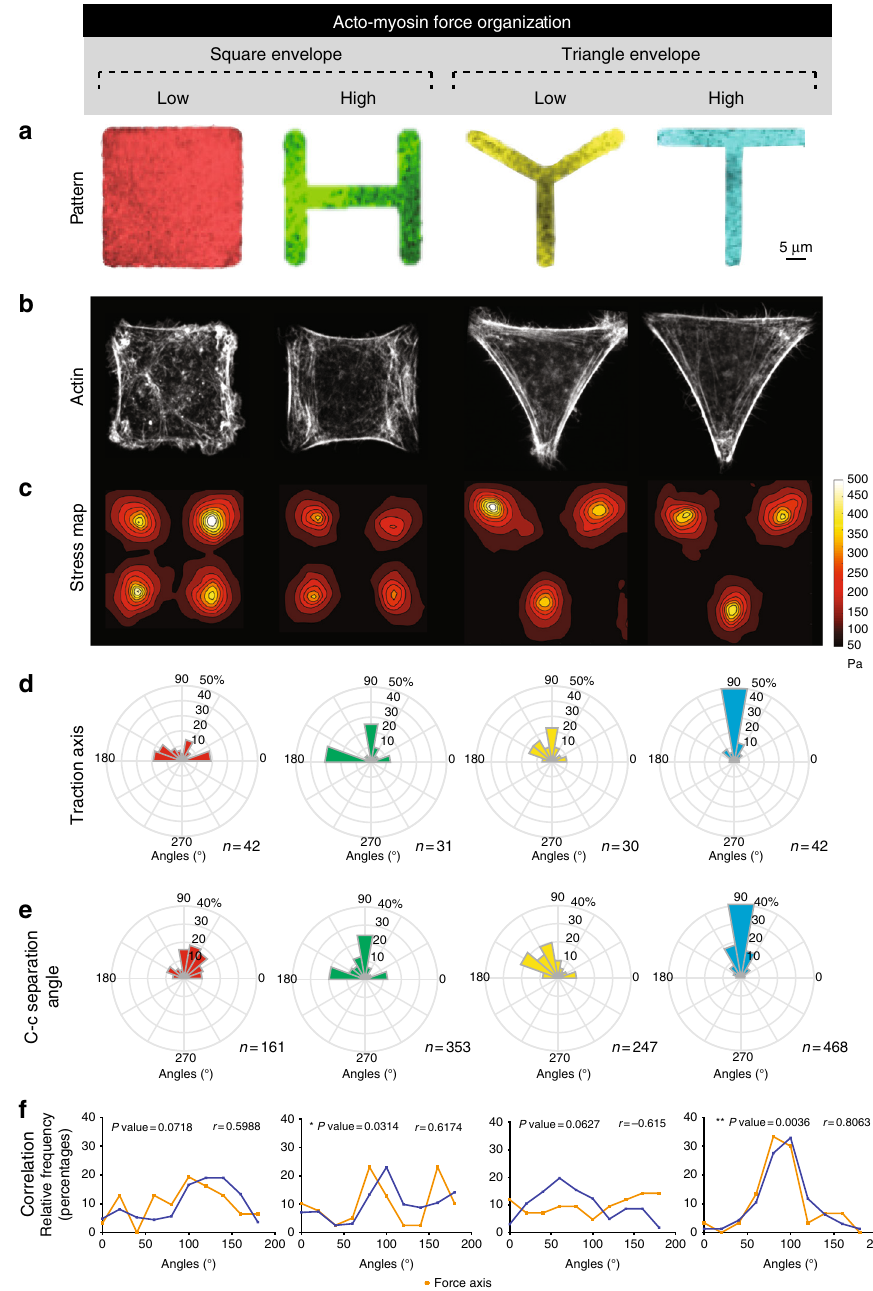
Fig. 2 Acto-myosin force organization regulates centriole separation. a Selected shapes for fi bronectin micropatterns printed on polyacrylamide hydrogels: Square in red, H in green, Tripod in yellow, and T in blue. Patterns have equivalent projected area (1000 μ m 2 ). b Phalloidin staining to decorate actin fi bers of Centrin1-GFP (C1-GFP) HeLa cells. c Stress map and d distribution of principal traction axis calculated for Square ( n = 42 cells), H ( n = 31 cells), Tripod ( n = 30 cells) and T ( n = 42 cells). These angles are restricted to the [0°, 180°] range as traction force axes are not directed. e Angle histogram of centriole-to-centriole axis (c-c separation angle). These angles are restricted to the [0°, 180°] range as centriole-to-centriole separation axes are not directed. f Correlation of angle distribution for Traction axis and c-c separation angle. Pearson test was used to estimate the correlation coef fi cient ( r ) and the statistical signi fi cance. For the r of H and T, p- values are 0.0314 and 0.0036 (scale bar = 5 μ